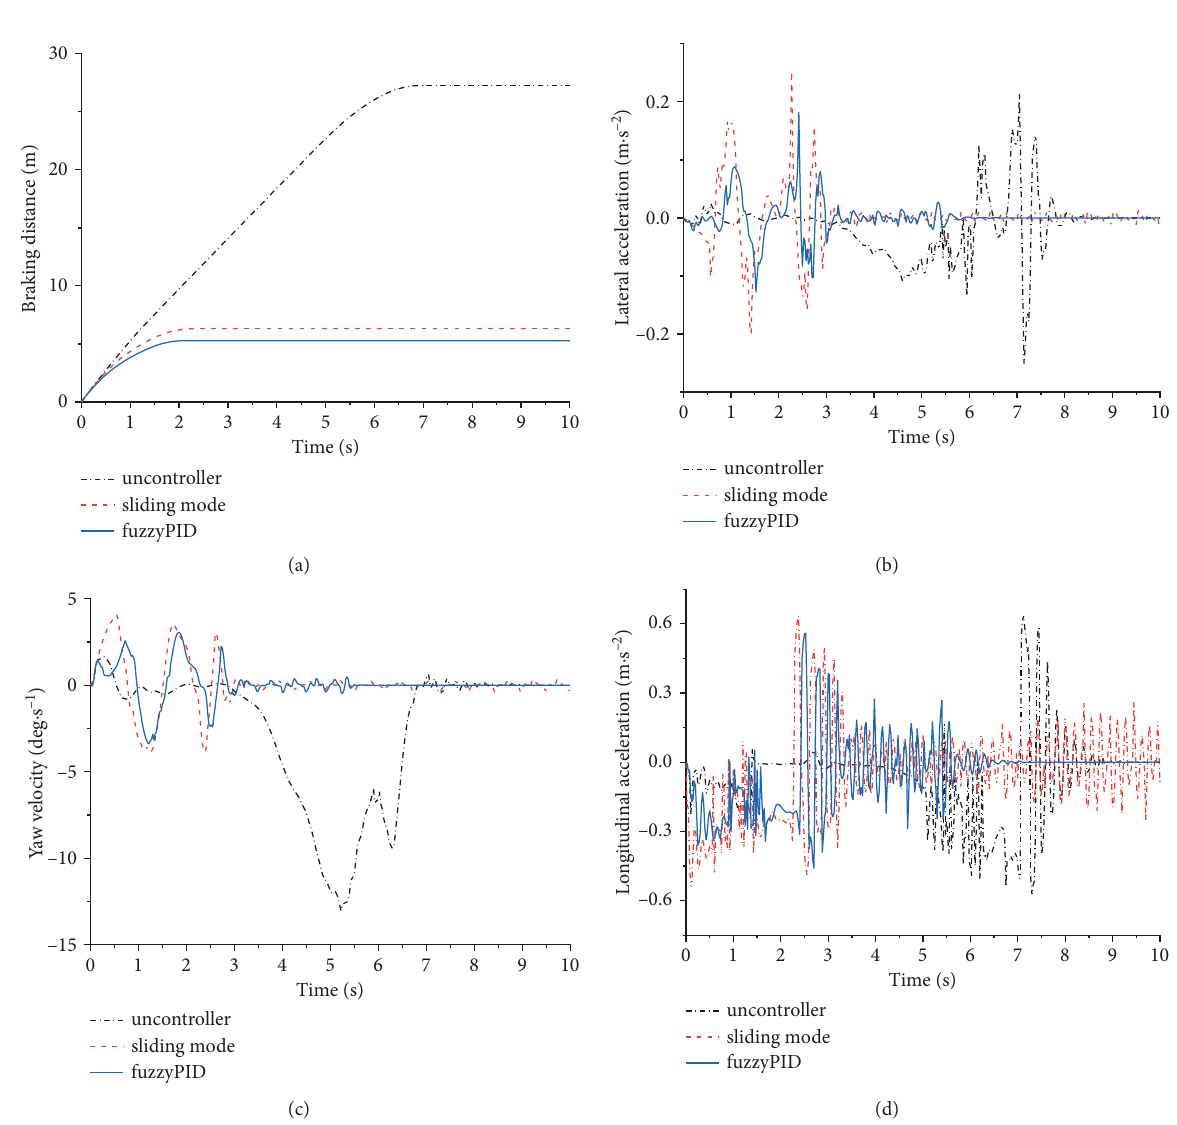
Figure 24: Simulation diagram of curve driving with braking efficiency of 50% at u � 0.75. (a) Braking distance. (b) Lateral acceleration. (c) Yaw velocity. (d) Longitudinal acceleration.